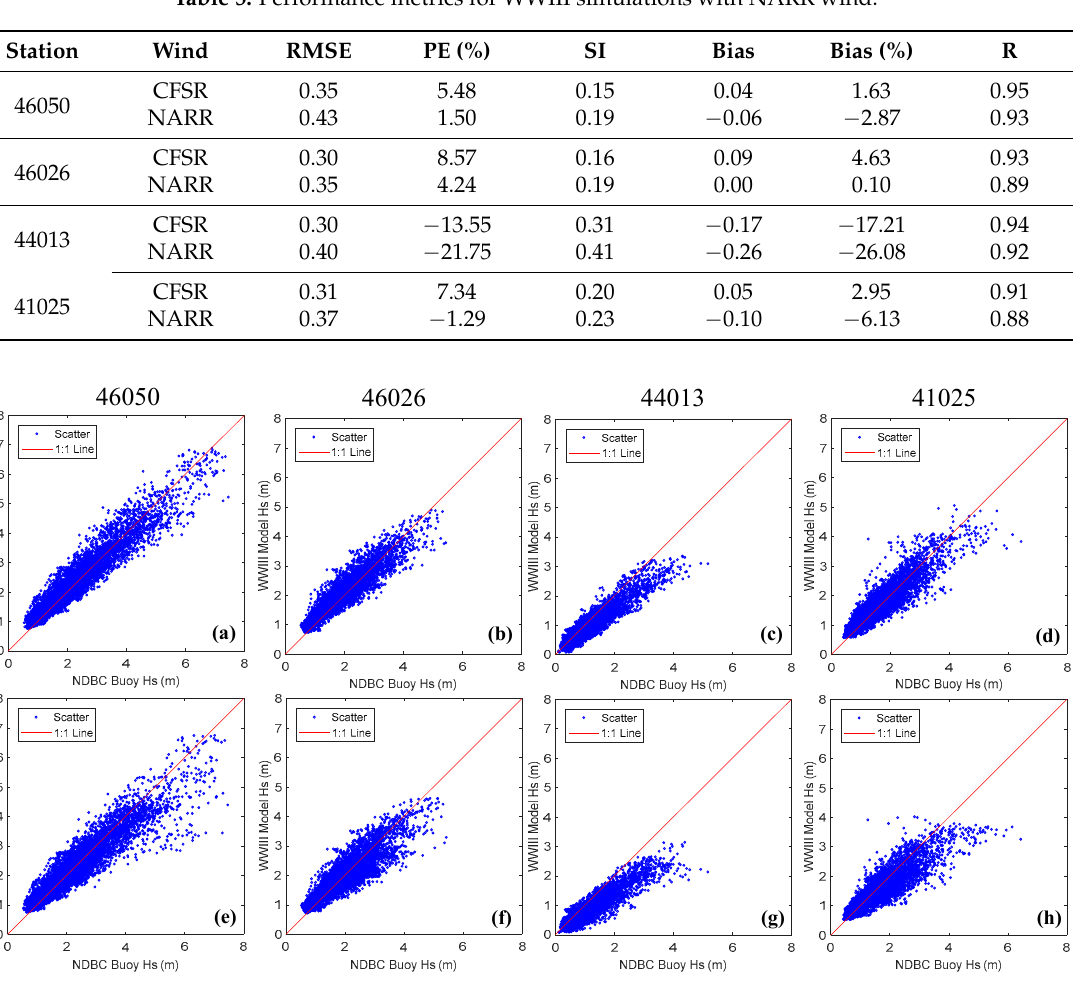
Figure 8. Scatterplot of WWIII-predicted significant wave height vs. buoy observations for the baseline condition with the CFSR wind forcing ( a – d ) compared with those for the sensitivity run using the NARR wind forcing ( e – h ) at all four buoys .